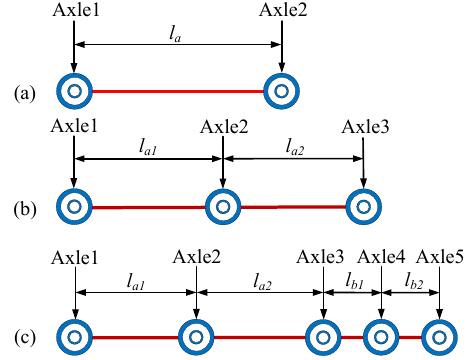
Figure 5. Adopted truck model: ( a ) 2-axle truck model; ( b ) 3-axle truck model; ( c ) 5-axle truck model.